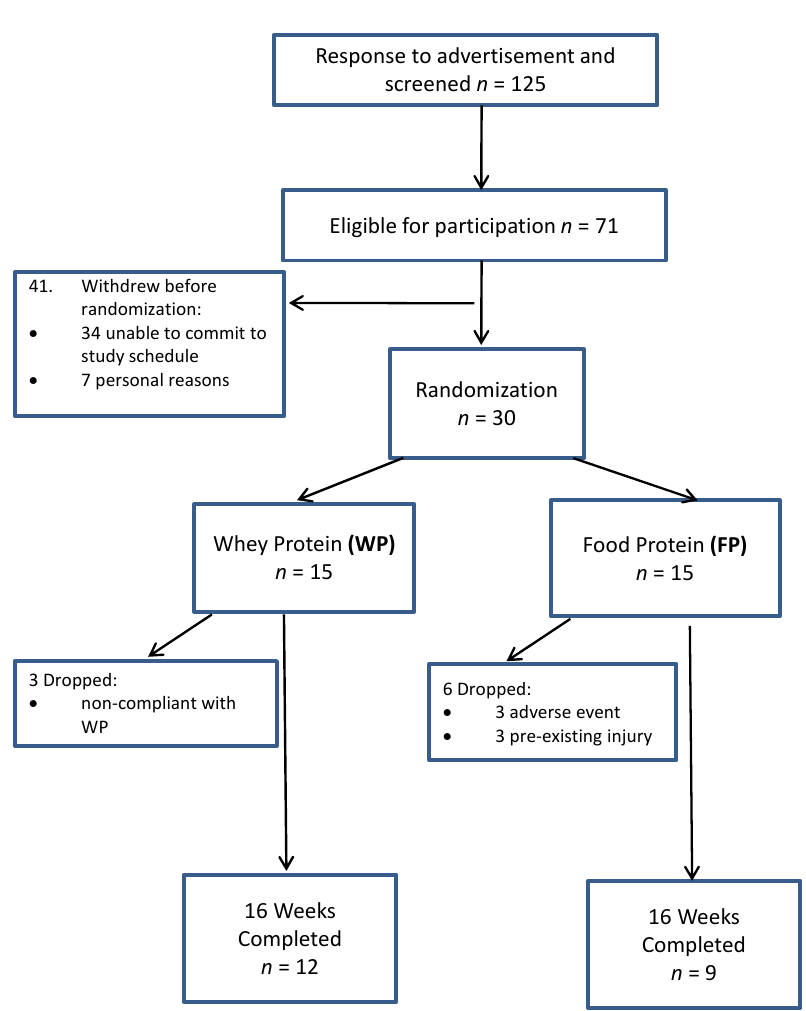
Figure 1. CONSORT (Consolidated Standards of Reporting Trials) flow chart of participants during the study intervention.